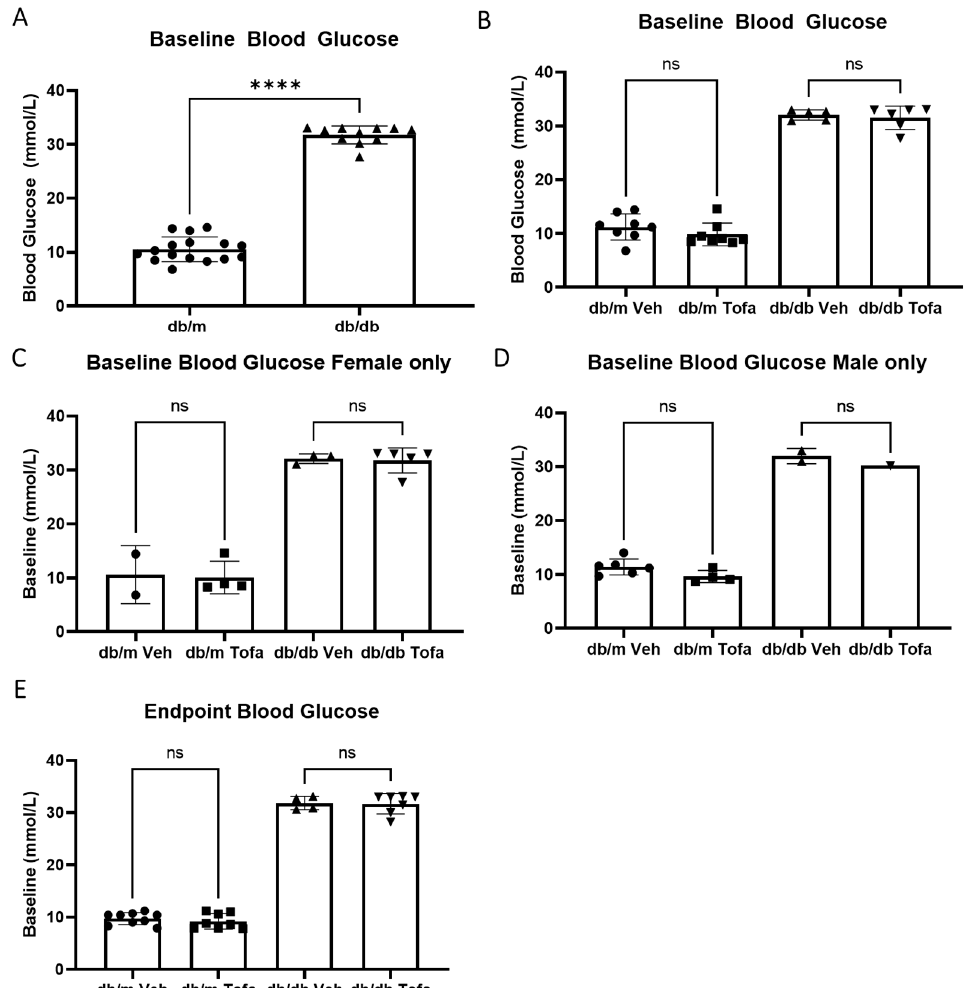
Figure 4. Tofacitinib citrate does not alter non-fasting blood glucose levels in db/db and db/m mice. Blood glucose measurements were taken from all mice between 2–3 pm at the beginning and end of the study. ( A ) db/db mice have higher levels of baseline blood-glucose than their db/m mice at 2.5 months of age. **** p < 0.0001 by Mann Whitney test. ( B ) Blood glucose levels in different groups of db/m and db/db mice before tofacitinib citrate (Tofa) or vehicle (Veh) treatment. ( C , D ) Blood glucose levels in female ( C ) and male ( D ) of different groups of db/m and db/db mice before tofacitinib citrate or vehicle treatment. ( E ) Endpoint blood glucose values in tofacitinib citrate or vehicle treated db/db and db/m mice. Mean ± SD, ns = not significant difference, Kruskall-Wallis test.